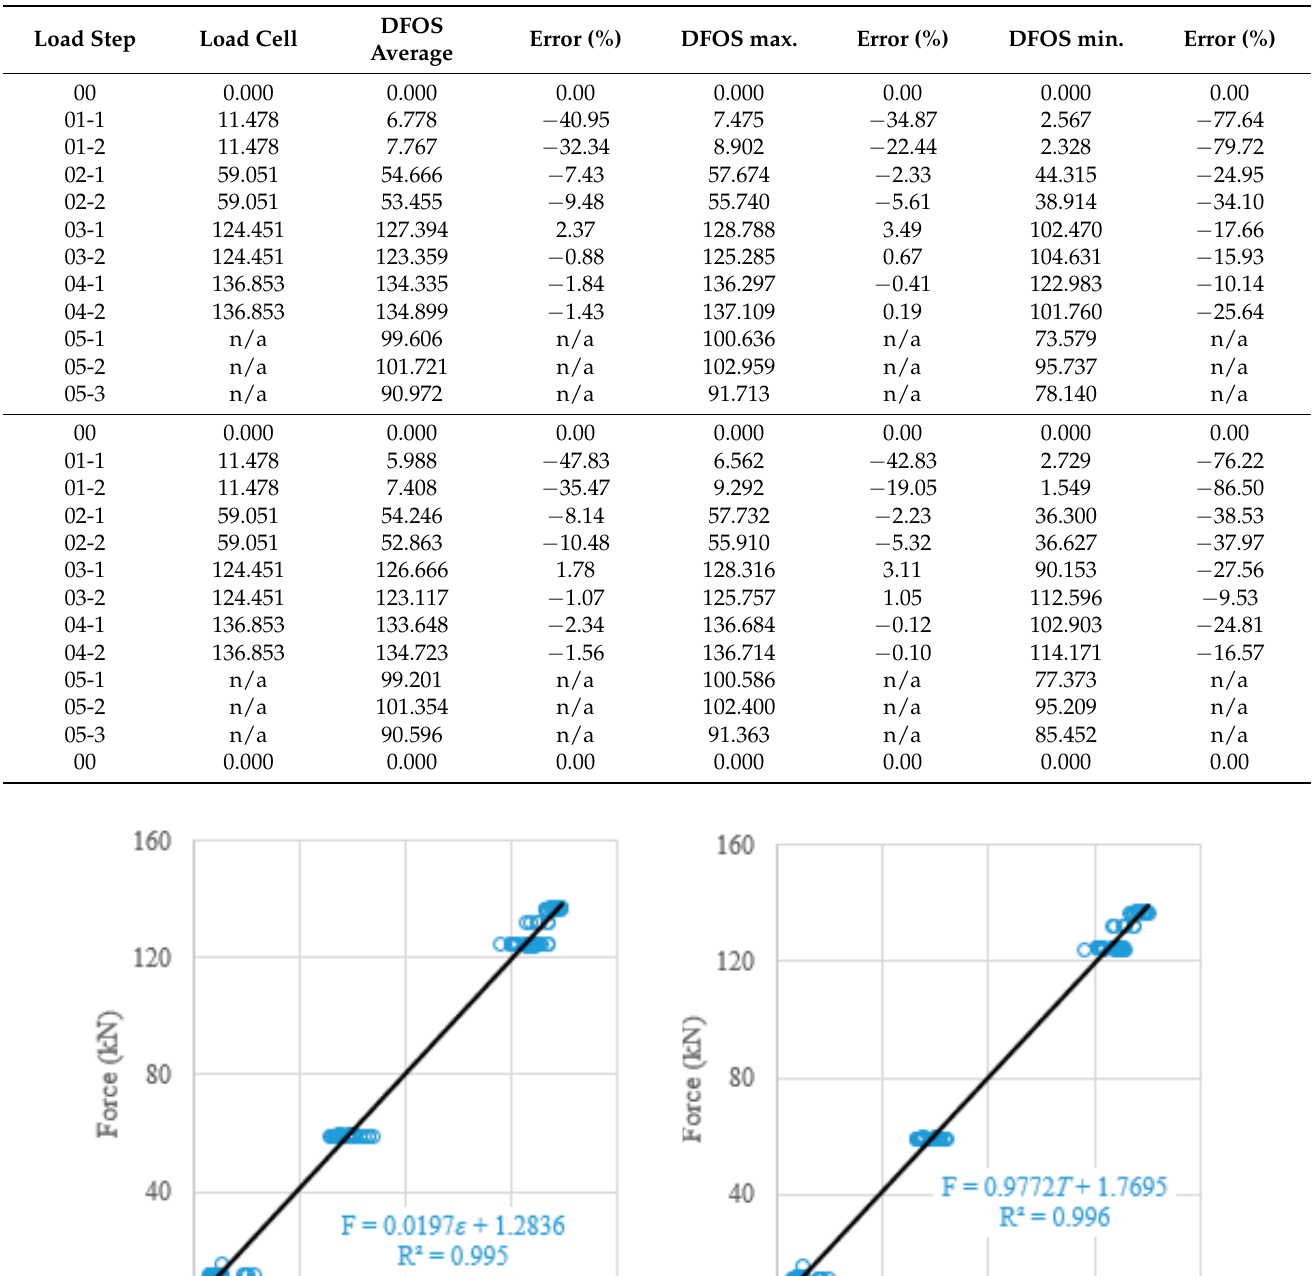
Table 11. Prestressing force monitored by load cell and DFOSs for PC4-2 (unit: kN).